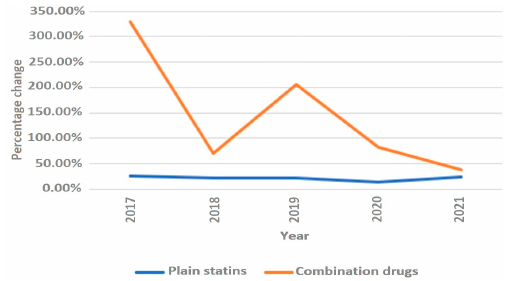
Figure 6. Annual rate of change in polypills and plain